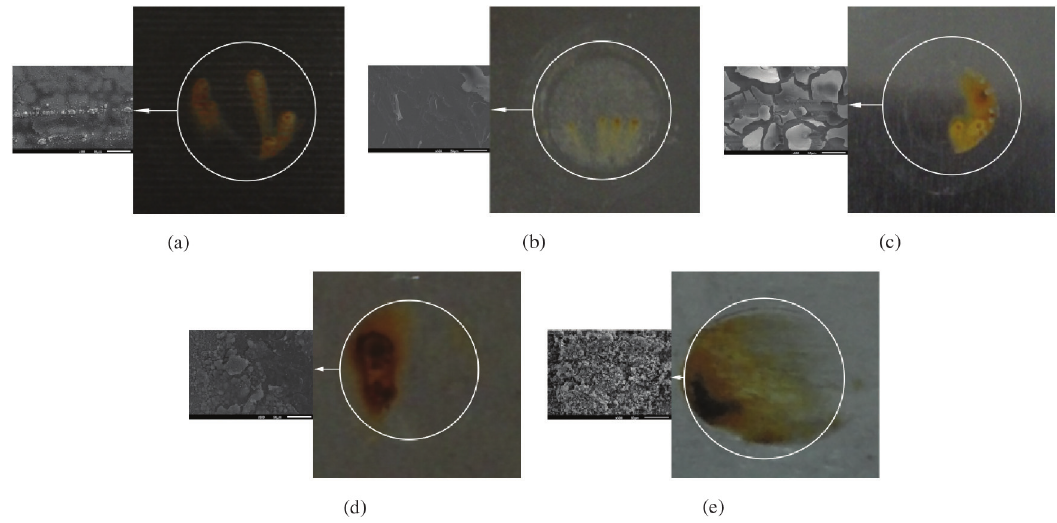
Figure 10. Images obtained for the samples: (a) F1P60M, (b) F1P60D, (c) F1P90M, (d) F1P90D and (e) FL after electrochemical impedance test.